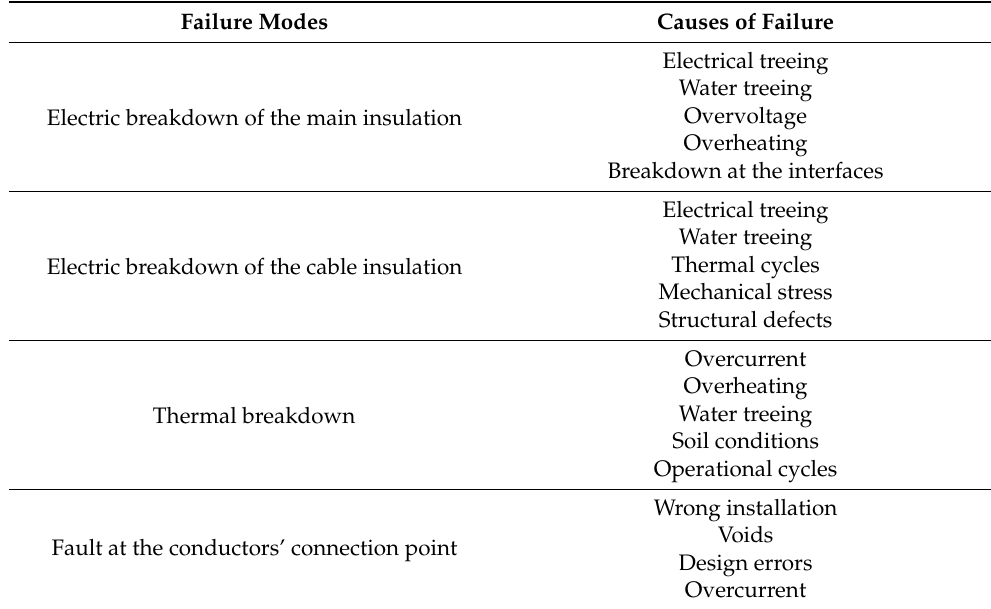
Table 1. Typical failure modes and causes of